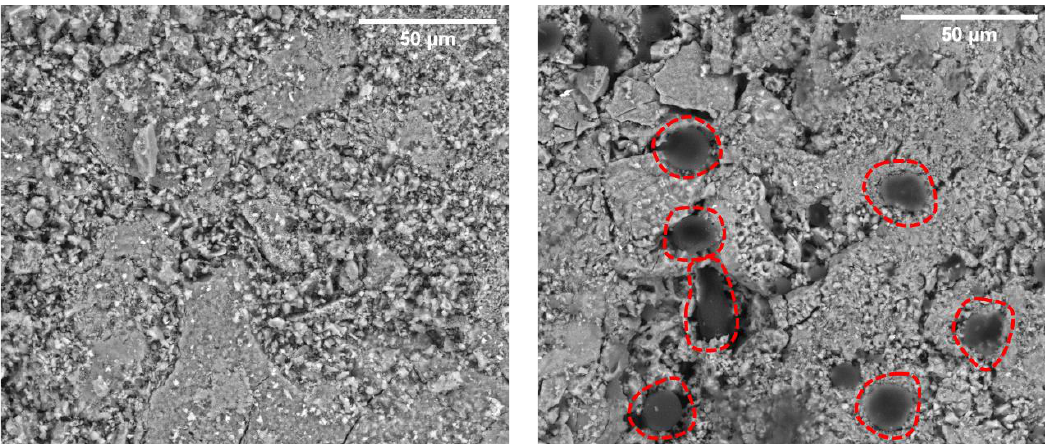
Figure 7. SEM analysis (backscattered electrons, 800×) of MnGC ( left ) and BMP-MnGC ( right ). The dark gelatinous spots surrounded by the red dotted lines are areas characterized by the presence of the anchored peptide. Scale bars represent 50 μ m.